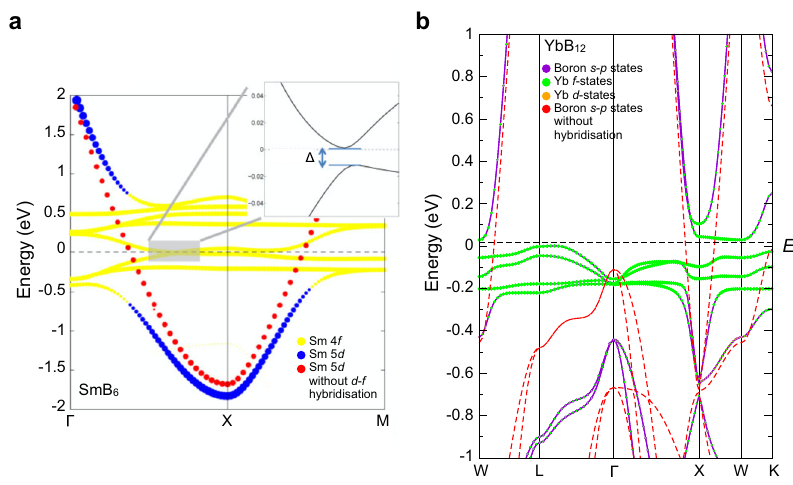
Fig. 5 Contrasting band structure of SmB 6 and YbB 12 . a Band structure of SmB 6 from GGA calculations in ref. 36 , zoomed in view near the Fermi energy E F (full energy range shown in ref. 36 ). Sizes of yellow and blue dots denote weights of Sm-4 f and Sm-5 d in various bands. Red dots denote metallic Sm-5 d orbitals without hybridisation with Sm-4 f orbitals. b Calculated band structure of YbB 12 shown with an expanded view around the Fermi energy E F (full energy range shown in ref. 4 ). Size of the circles are proportional to the weight at each k -point, green circles are Yb f -states, orange circles are Yb d -states, and violet circles are boron s-p -states. Red dots denote two partially fi lled unhybridised boron s - p conduction electron orbitals without hybridisation with Yb- f orbitals. In both cases, the Fermi surface yielded by the unhybridised band is not simply connected, leading to a large number of expected frequencies 1,4